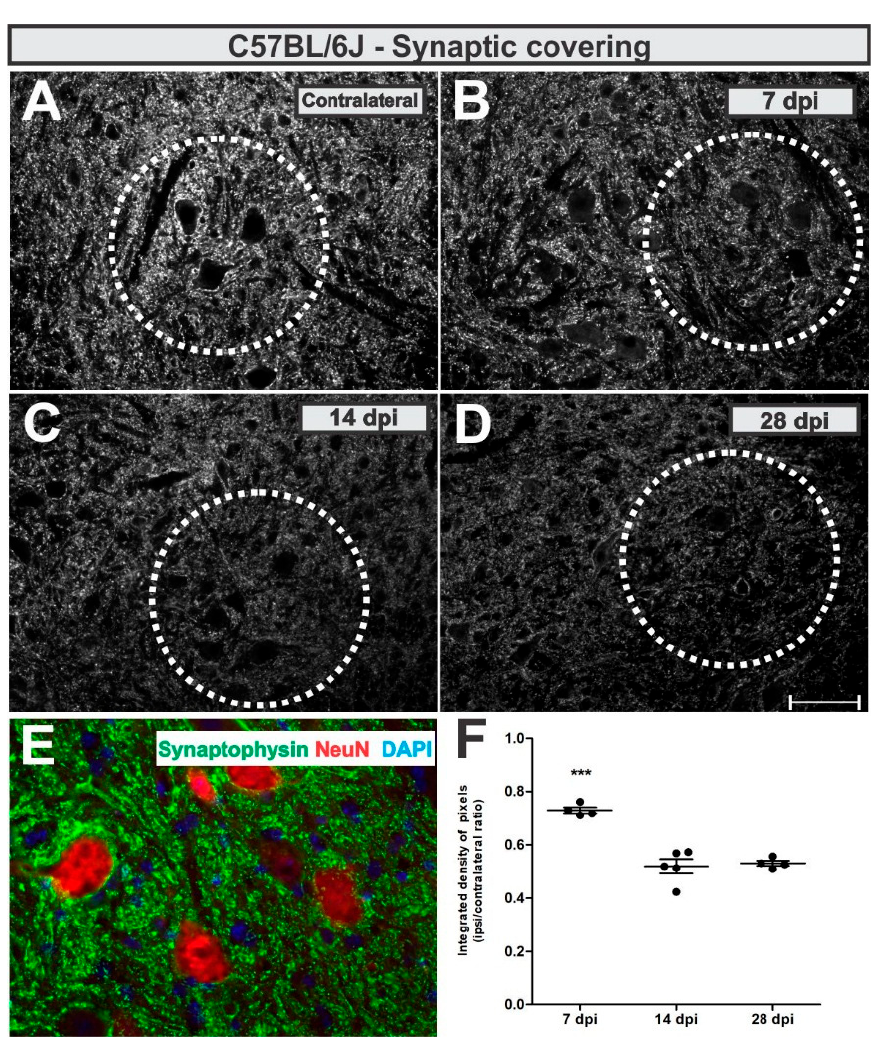
Figure 5. Synaptic covering in WT mice. ( A ) representative contralateral image, ( B ) 7 dpi, ( C ) 14 dpi and ( D ) 28 dpi. ( E ) illustrates the synaptic inputs (in green) to ipsilateral motoneuron-like cells, labelled with NeuN (in red). ( F ) Comparative quantification among time points (ipsi / contralateral ratio); p < 0.001 (***). Scale bar = 50 µ m.